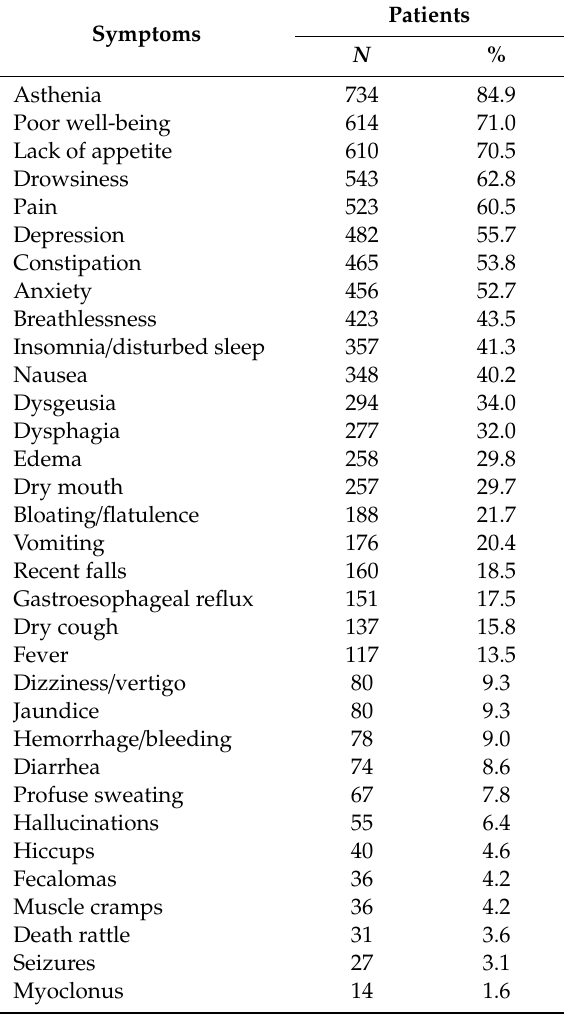
Table 2. Prevalence of symptoms in decreasing order of frequency among the 865 patients at baseline. Patients Symptoms